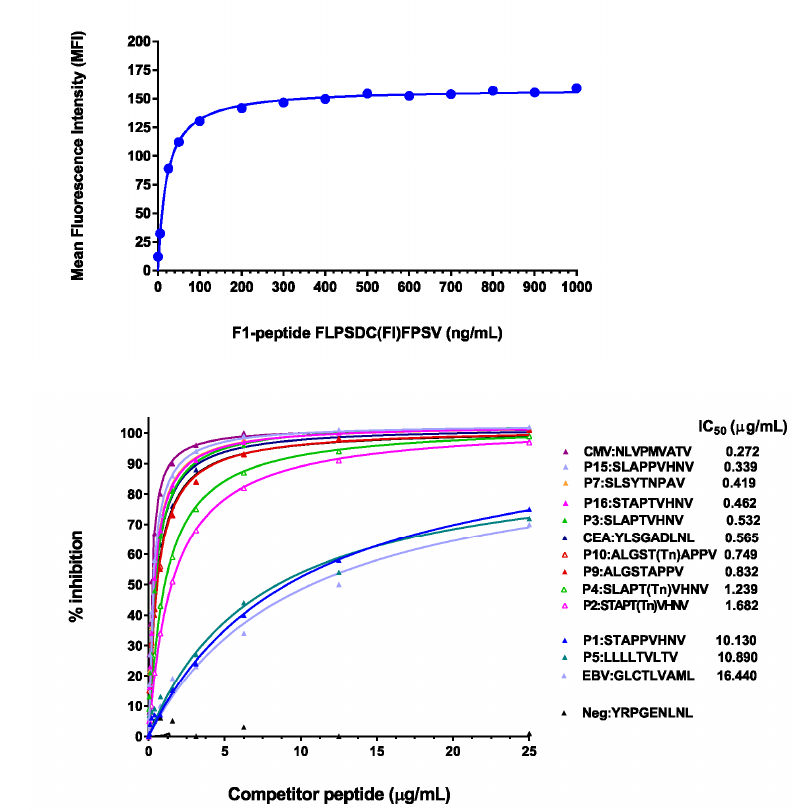
Figure 2. Peptide modifications increased binding affinities for HLA-A*0201 molecules ( A ) Titration of the reference peptide. The Hepatitis B core antigen (residues 18–27), an HLA-A*0201-binding peptide (FLPSDFFPSV), was synthesized with a cysteine residue substituted for the F (FLPSDCFPSV). This cysteine was conjugated to fluorescein (F1-peptide) for use in competitive inhibition studies. Recombinant β 2-microglobulin (1 µ g/mL) and the F1-peptide (concentrations shown on x-axis) were added to T2 cells and incubated for 18 h at 26 ˝ C in a 5% CO 2 incubator. Mean fluorescence intensity (MFI) was determined for the F1-peptide concentrations using flow cytometry; ( B ) MUC1 peptides (anchor-optimized and glycosylated) competed effectively with the F1-peptide. T2 cells were incubated with the reference peptide (F1-peptide, 100 ng/mL), β 2-microglobulin (1 µ g/mL) and increasing amounts of unlabeled MUC1 peptides (competitor peptides). The concentrations that produced 50% inhibition of the F1-peptide by the competitor peptides (IC 50 ) were calculated as follows: (1 ´ (MFI T2 + F1-peptide + modified peptide ´ MFI T2 only)/(MFI T2 + F1-peptide ´ (MFI T2 only)) ˆ 100. The software program Prism was used. Peptides were arbitrarily scored as low affinity binding peptides with IC 50 of more than 15 µ g/mL, medium affinity binding peptides with IC 50 of more than/equal to 5 µ g/mL and less than/equal to 15 µ g/mL, and high affinity binding peptides with IC 50 of less than 5 µ